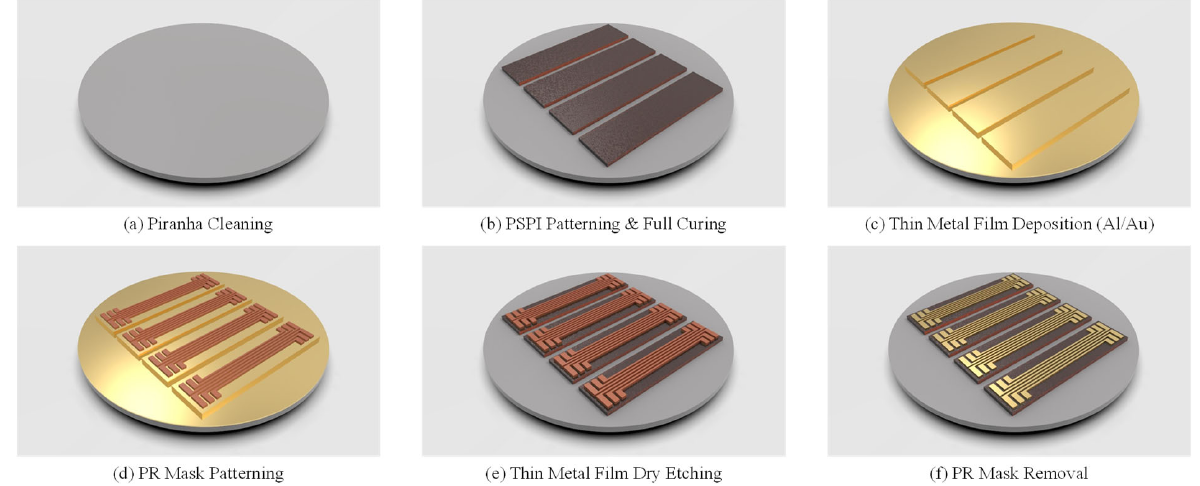
Figure 8. Thin-film metal test pattern fabrication process. ( a ) Piranha cleaning for removing organic residues from Si substrates, ( b ) Spin − coating, UV exposure, developing process, and Full curing in vacuum condition for PSPI patterning, ( c ) Thin metal film (Al and Au) deposition using an E − beam evaporation process. ( d ) Positive photoresist patterning for thin metal film etching mask, ( e ) The ICP − RIE − based dry etching process for thin metal film patterning, ( f ) The Oxygen plasma − based dry etching process for photoresist removing .